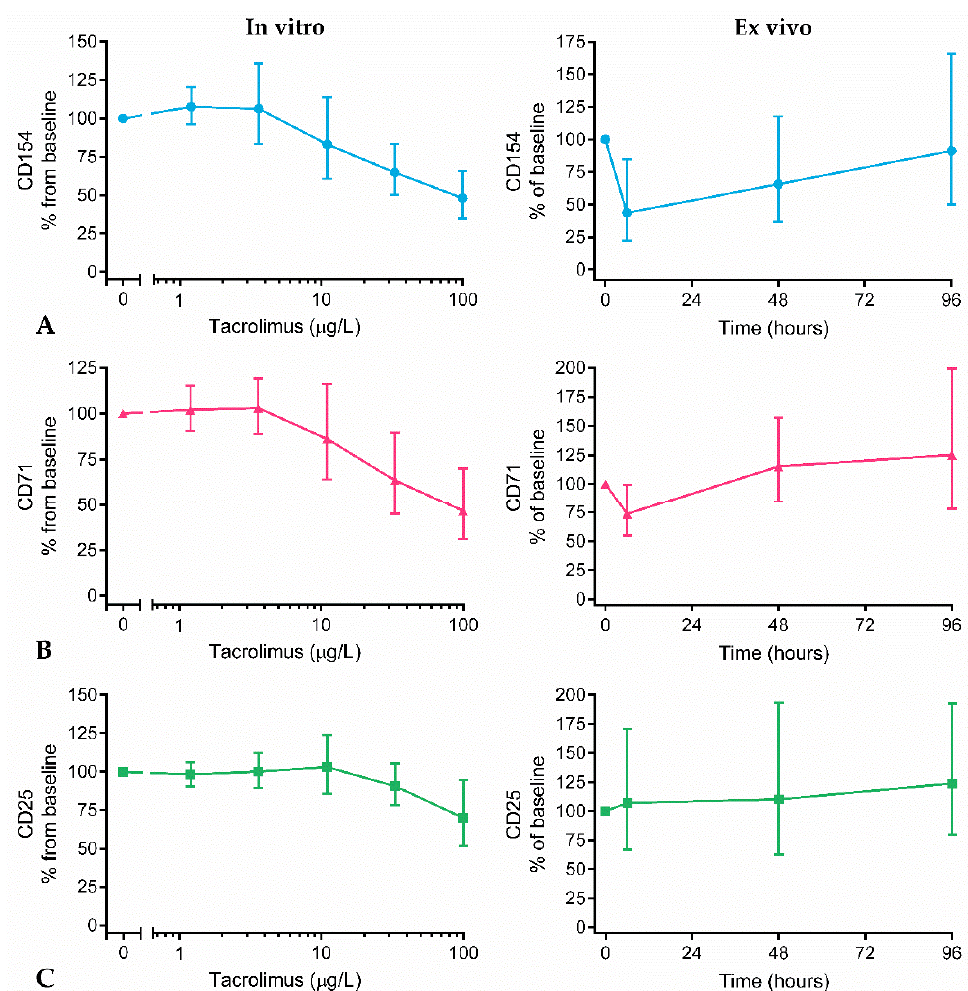
Figure 4. In vitro and ex vivo tacrolimus effect on expression of ( A ) CD154 (blue lines), ( B ) CD71 (red lines), and ( C ) CD25 (green lines) on CD3+ T cells after 48 h whole blood stimulation with PHA. In vitro tacrolimus effect: pre-dose surface marker expression after co-incubation with different tacrolimus concentrations (100, 33, 11, 3.7 and 1.2 μ g/L). Ex vivo tacrolimus effect: surface marker expression over time, after PHA stimulation of whole blood samples collected from tacrolimus-exposed subjects. The expression was calculated as percentage of baseline, and is displayed as mean ± SD.